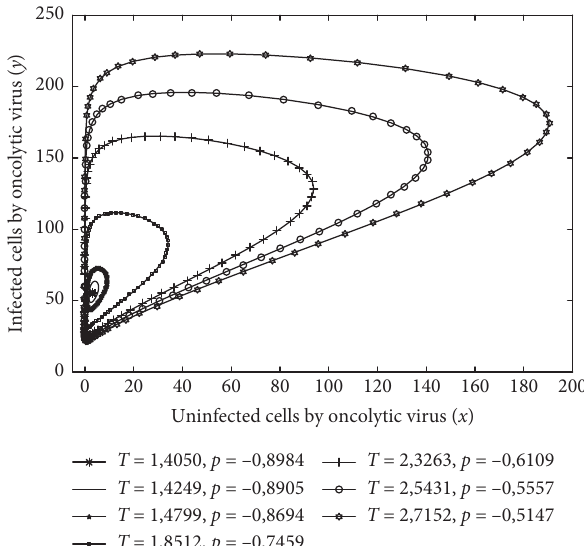
Figure 3: The periodic solutions for some values of the parameter p with period T.